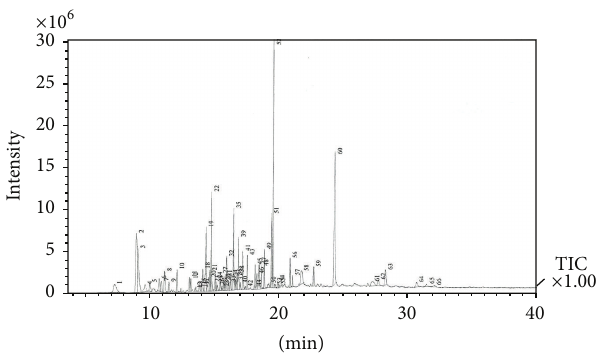
Figure3:Gaschromatography-massspectrometryprofileof Andro- graphis paniculata leaf